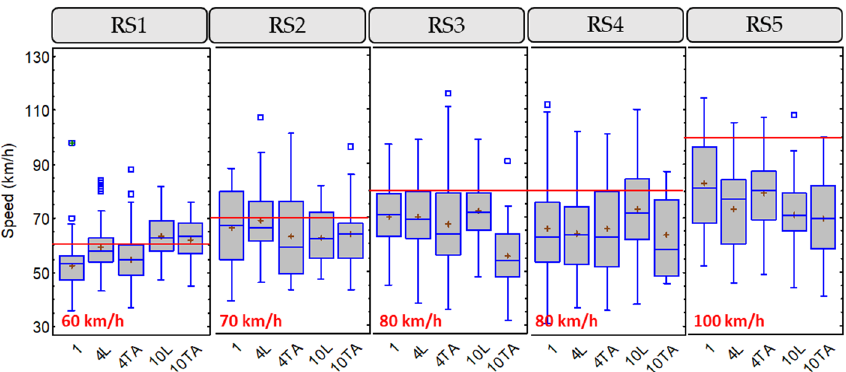
Figure 6. Box-and-whisker plot for overtaking speed, considering road segment and group